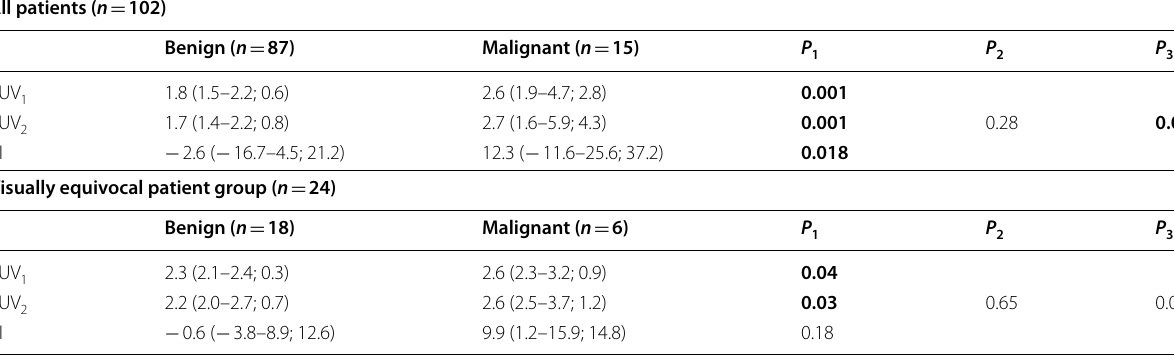
measurements 70